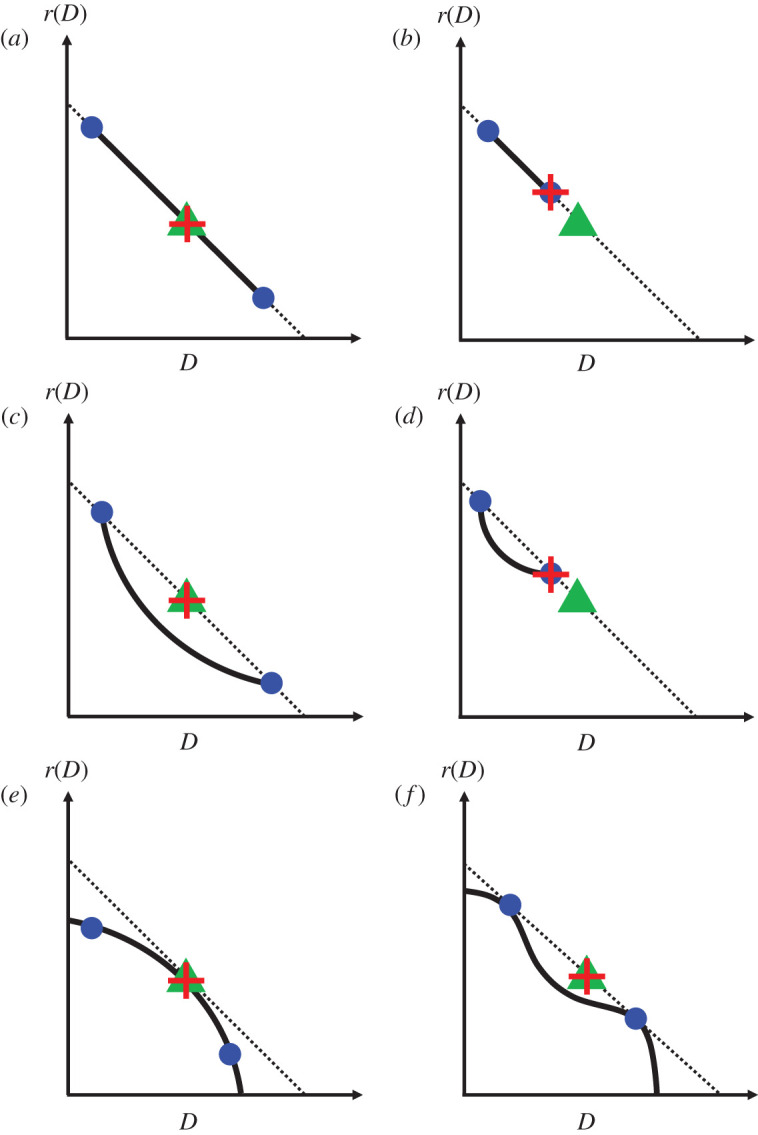
The geometry of the D–r trade-off determines which anomalous speeds, if any, give the eventual invasion speed for a species comprising a continuum of strains. Solid lines represent the trade-off curve between D and r. Dotted lines are chords that pass through points on the trade-off curve and terminate at the axes. Green triangles are the midpoint of these chords, and represent the ‘virtual strain’ for any two strains that the chord passes through (see text). Blue points represent two particular strains of the species. The invasion speed in each case is given by 2D+r+, where D+ and r+ are the values of D and r evaluated at the red crosses. Panels a,b: for a straight-line trade-off, all pairs of species have the same chord and therefore the same virtual strain. In a, the virtual strain is a constituent of the species, but not in b. In c, the virtual strain for the two extreme strains (blue circles) lies between them, and since the trade-off curve lies below this chord the virtual strain has a faster speed than any single constituent. In b,d, the virtual strain does not lie between any pair of points on the trade-off curve, so does not yield a valid anomalous invasion speed. If the trade-off has negative curvature (e) there are valid anomalous speeds, but none of their virtual strains lie above the trade-off so the asymptotic invasion speed is the fastest constituent monomorphic speed. In f, the chord is tangential to the trade-off at the two blue points, and since the whole trade-off curve lies below this chord the corresponding anomalous speed is faster than any other monomorphic or dimorphic speed for this species. This shows that the vanguard strains are not necessarily the ones with the highest values of r or D. We show further in the Methods section that the vanguard strains do not necessarily have the highest value of rD either.